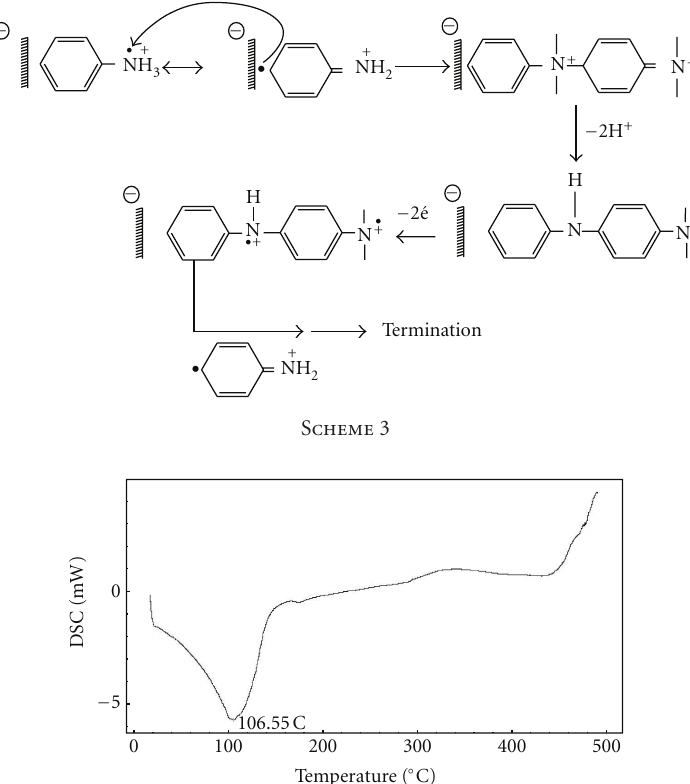
Figure 6: DSC Curve of Maghnite-Na + obtained in nitrogen atmosphere at heating rate of 10 ◦ C/min. Fig.: Experiment: POANI-ES Labsys TM TG Procedure: from 20–600 ◦ C (Seq 2)